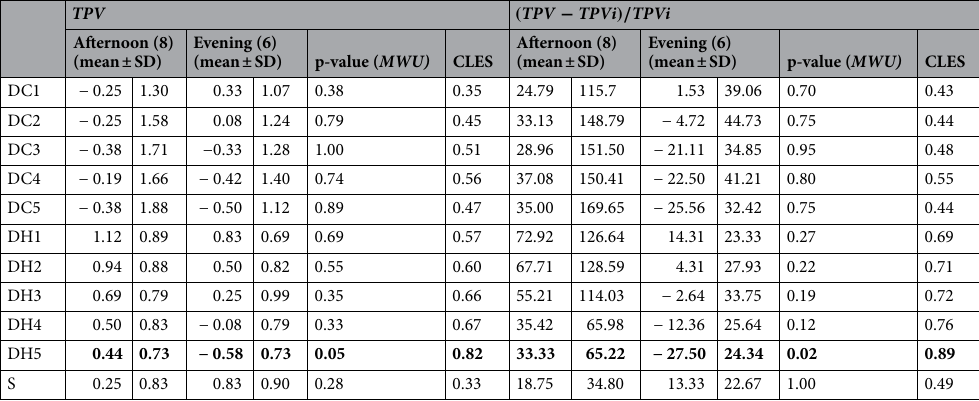
Table 6. Time-of-day differences in thermal sensation vote and its relative change over the course of the last two partial-body cooling and warming transients. Significant values are in